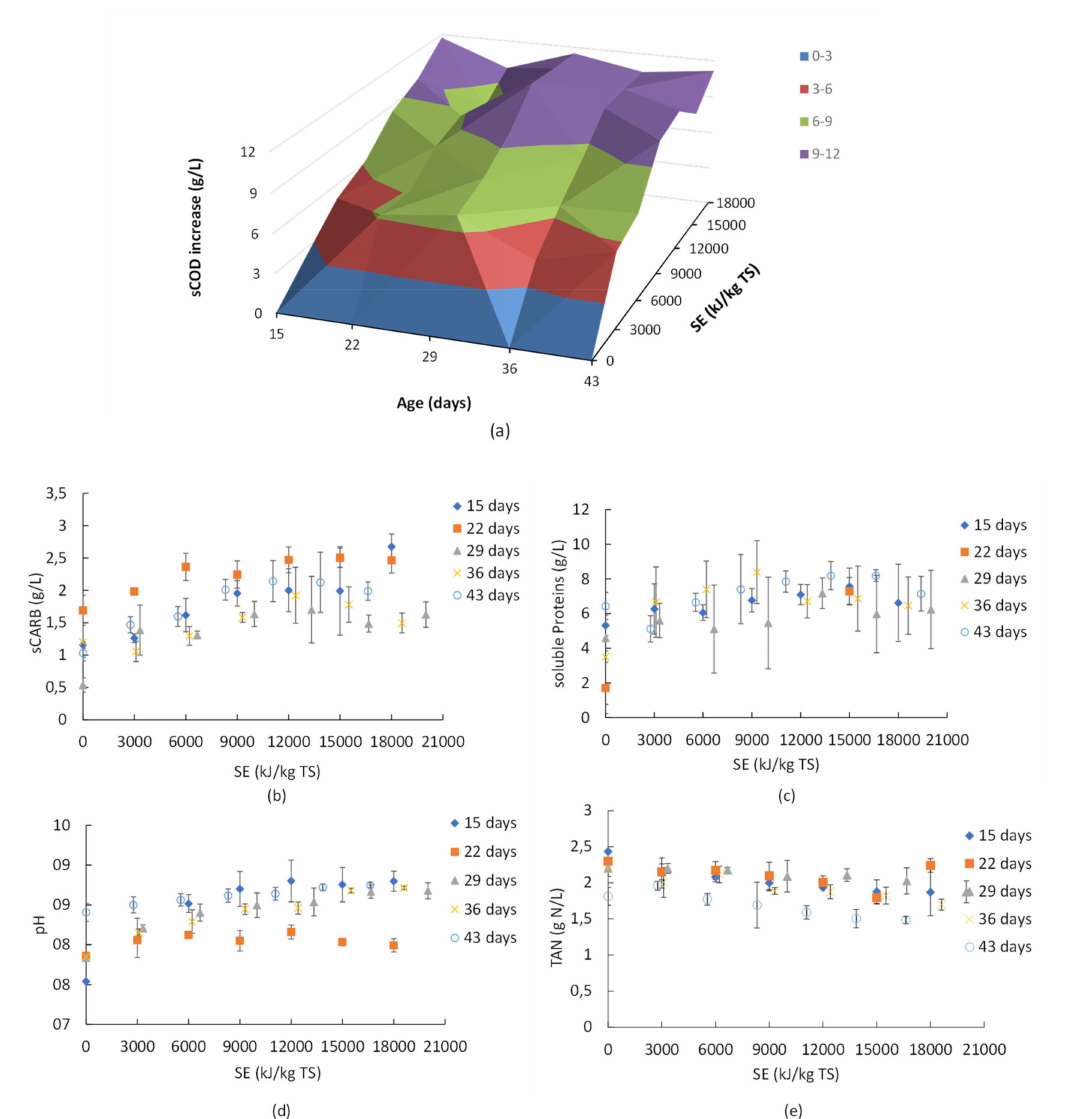
Figure 2. The effect of ultrasound (US) disintegration on biochemical parameters with ( a ) the absolute soluble chemical oxygen demand (sCOD) increase; ( b ) the soluble carbohydrate (sCARB), ( c ) the soluble protein content sPROT, ( d ) the pH and ( e ) the total ammonia nitrogen (TAN) concentration profiles in function the applied SE and the digestate